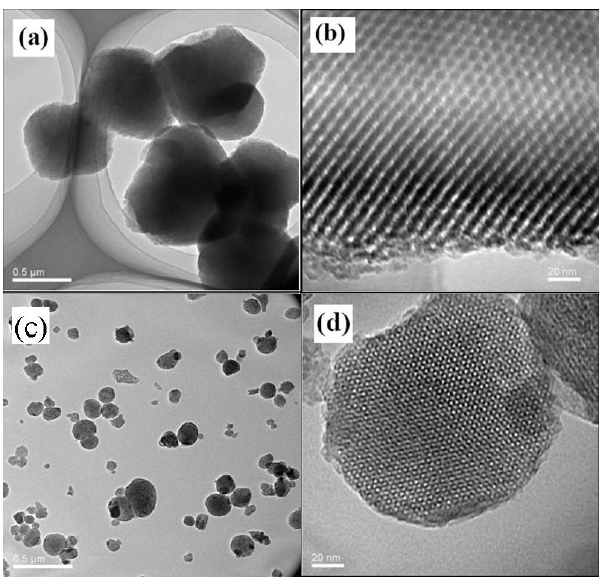
Figure 17. TEM (transmission electron microscopy) images of the as-made SBA-15 ( a , b ) and MCM-48 ( c , d ) [38].